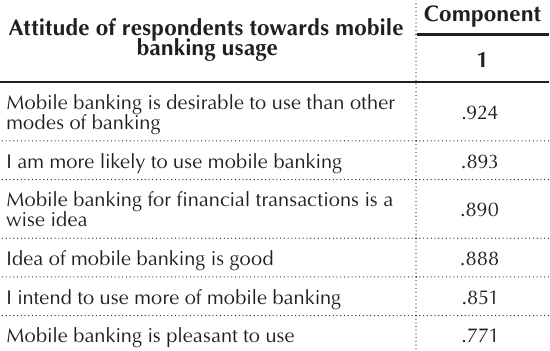
Table 11. (cid:4)(cid:427)(cid:410)(cid:437)(cid:282)(cid:286)(cid:3)(cid:381)(cid:296)(cid:3)(cid:396)(cid:286)(cid:400)(cid:393)(cid:381)(cid:374)(cid:282)(cid:286)(cid:374)(cid:410)(cid:400)(cid:3)(cid:410)(cid:381)(cid:449)(cid:258)(cid:396)(cid:282)(cid:400)(cid:3) (cid:373)(cid:381)(cid:271)(cid:349)(cid:367)(cid:286)(cid:3)(cid:271)(cid:258)(cid:374)(cid:364)(cid:349)(cid:374)(cid:336)(cid:3)(cid:437)(cid:400)(cid:258)(cid:336)(cid:286)